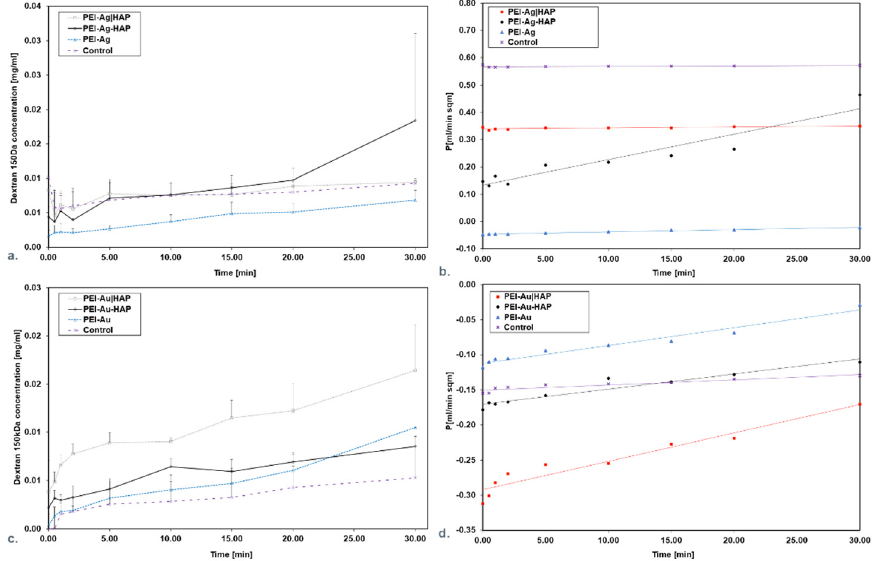
Figure 5. Dextran 150 concentration in the function of time during permeation through the membrane scaffolds containing silver ( a ) or gold ( c ) nanoparticles. Membrane permeability and time product during particular time intervals permeation for Dextran 150 through the membrane scaffolds containing silver ( b ) or gold ( d ) nanoparticles. Key to symbols: PEI-Ag: polyethyleneimine with AgNPs; PEI-Ag|HAP: polyethyleneimine with AgNPs—hydroxyapatite; PEI-Ag-HAP: polyethyleneimine with AgNPs and HAP complex. PEI-Au: polyethyleneimine with AuNPs; PEI-Au|HAP: polyethyleneimine with AuNPs—hydroxyapatite; PEI-Au-HAP: polyethyleneimine with AuNPs and HAP complex. The values are presented as mean ±SD.